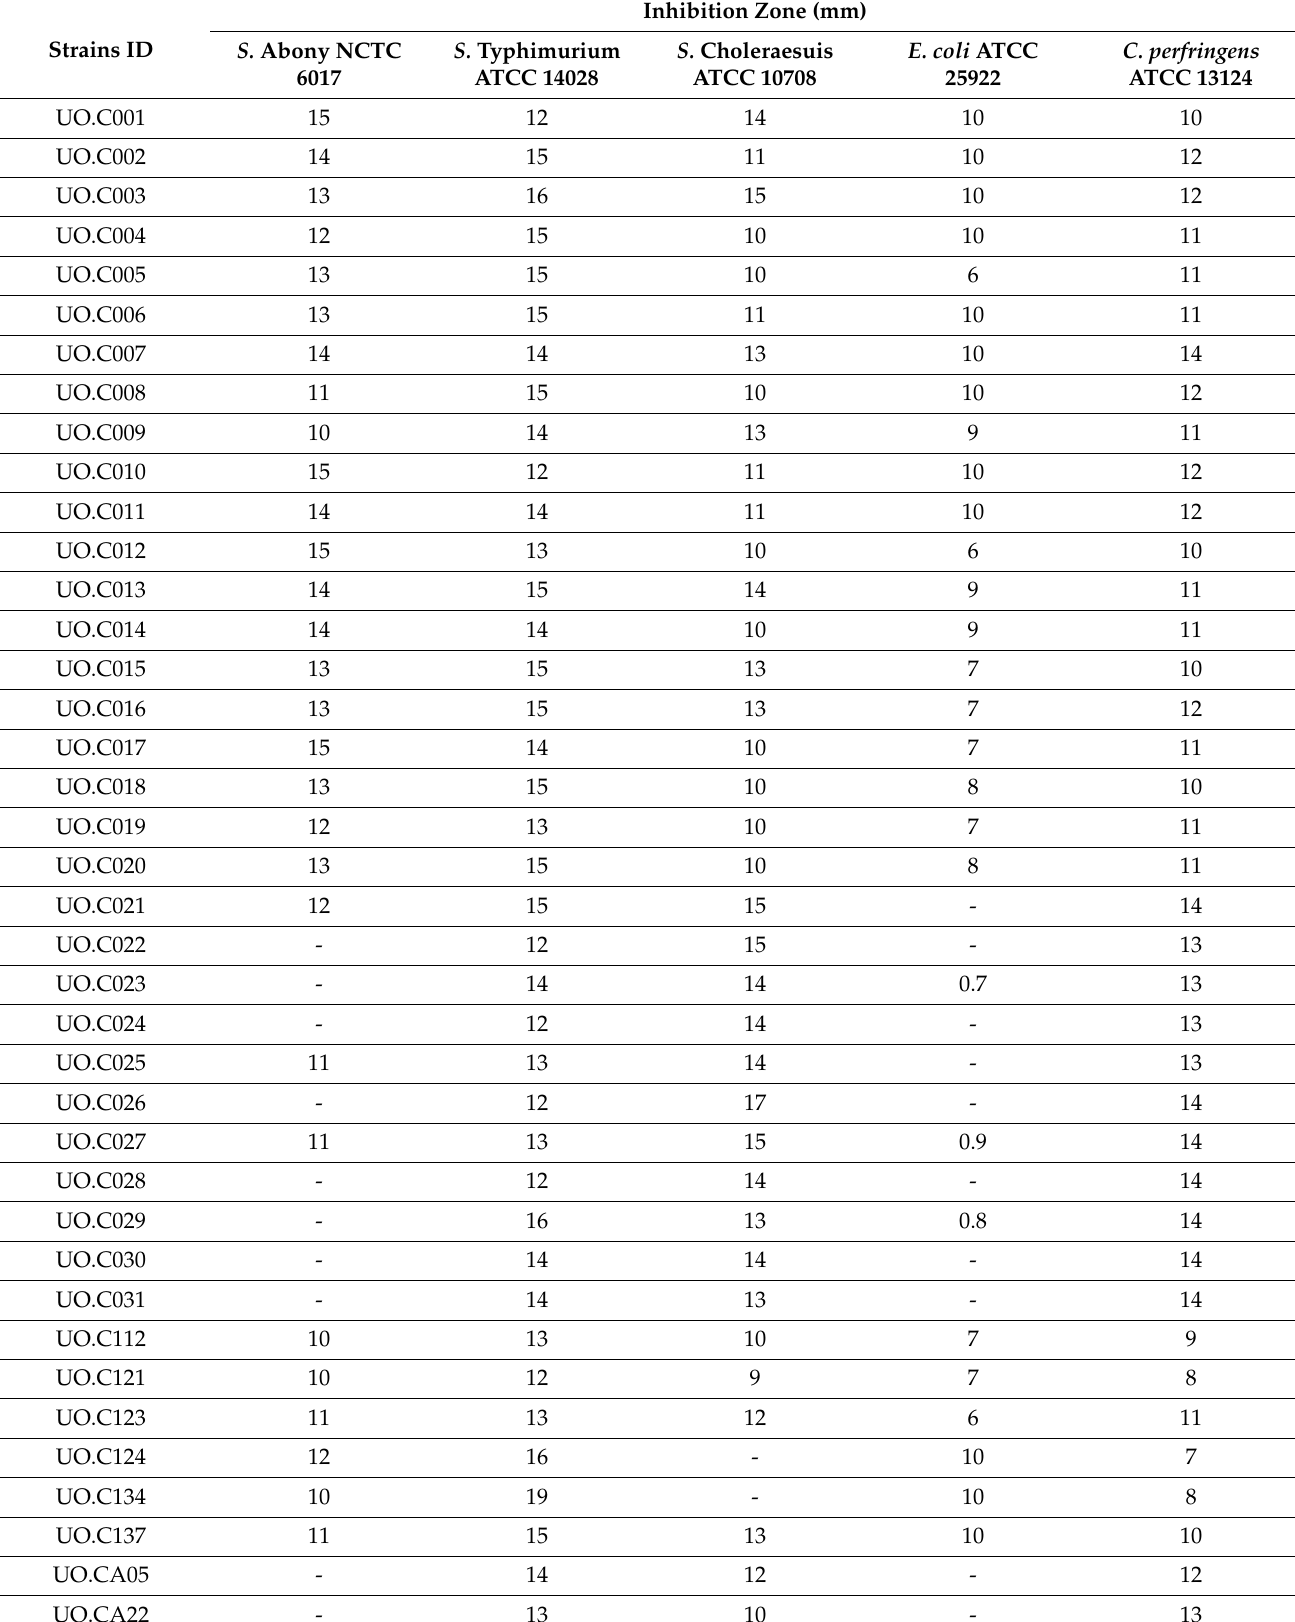
Table 1. Determining the diameter of indicator strain inhibition by cell-free supernatants extracted from bioactive isolated strains in this